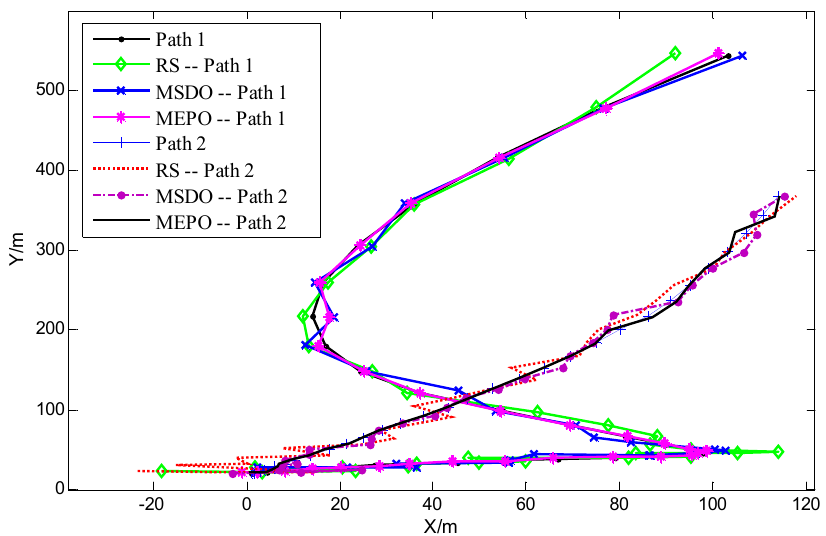
Figure 6. The trajectories of using RS, MSDO, MEPO node selection methods for path 1 and path 2.